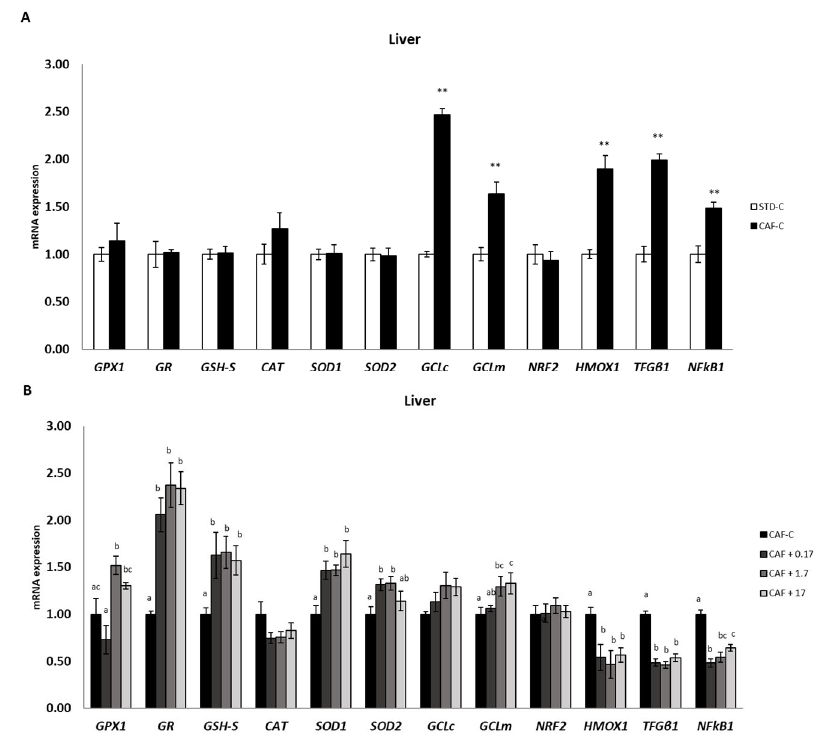
Figure 2. mRNA expression in liver. All values are means ± standard error of the mean (SEM). Differences between rats fed standard (STD) diet and supplemented with vehicle (STD ‐ C, n = 8) and rats fed cafeteria (CAF) diet and supplemented with vehicle (CAF ‐ C, n = 8) ( A ) were assessed by using Student’s t parametric test ( t test) for independent samples: **, significantly different compared to the STD ‐ C group ( p < 0.01). Differences among CAF ‐ C rats, rats fed CAF diet and supplemented with 0.17 mg kg − 1 body weight (bw) per day of TetraSOD ® (CAF + 0.17, n = 8), rats fed CAF diet and supplemented with 1.7 mg kg − 1 bw of TetraSOD ® (CAF + 1.7, n = 8) and rats fed CAF diet and supplemented with 17 mg kg − 1 bw of TetraSOD ® (CAF + 17, n = 8) ( B ) were evaluated by the ANCOVA test, using the percentage of body fat in the 8th week (before treatment) as a covariable: abc letters indicate statistically significant differences among the CAF groups ( p < 0.05). CAT, catalase; GCLc, glutamate–cysteine ligase, catalytic subunit; GCLm, glutamate–cysteine ligase, modifier subunit; GPx1, glutathione peroxidase 1; GR, glutathione reductase; GSH ‐ S, glutathione synthetase; HMOX1, heme oxygenase 1; NF κ B1, nuclear factor kappa B subunit 1; NRF2, nuclear factor, erythroid 2 ‐ like 2; SOD1, superoxide dismutase 1; SOD2, superoxide dismutase 2; TGF β 1, transforming growth factor beta 1.